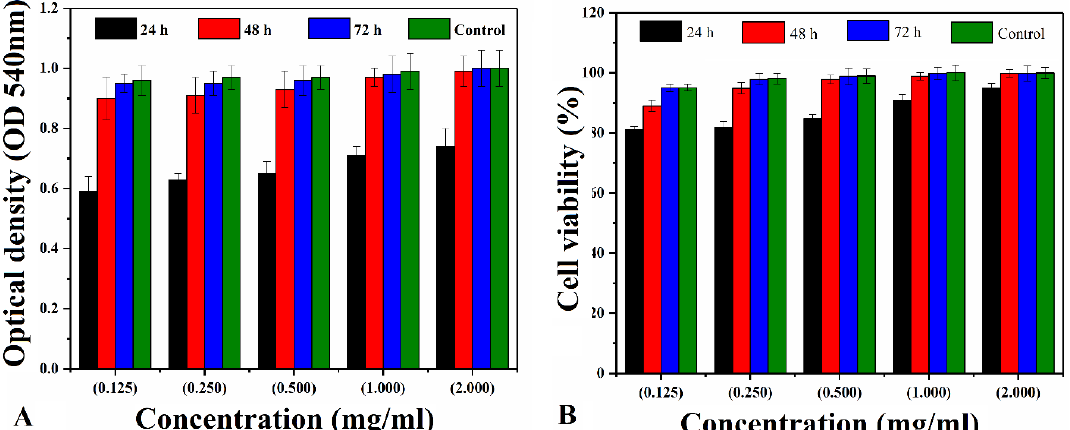
Figure 8. Different concentrations of extract were used to estimate percentage cell viability on mouse preosteoblast cell line MC3T3-E1 for 24, 48, and 72 h of time points. ( A ) shows the optical density of absorbed neutral red dye at 540 nm while ( B ) represents the relative percentage of cells compared to control.